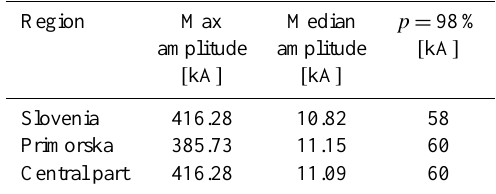
Table 1. Data on lightning strokes in